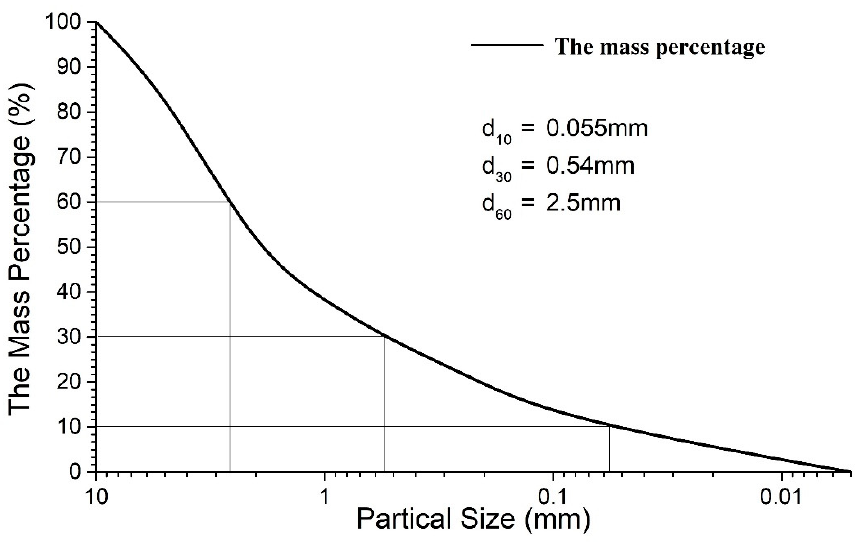
Figure 1. Gradation curve of coral sands used in the tests.